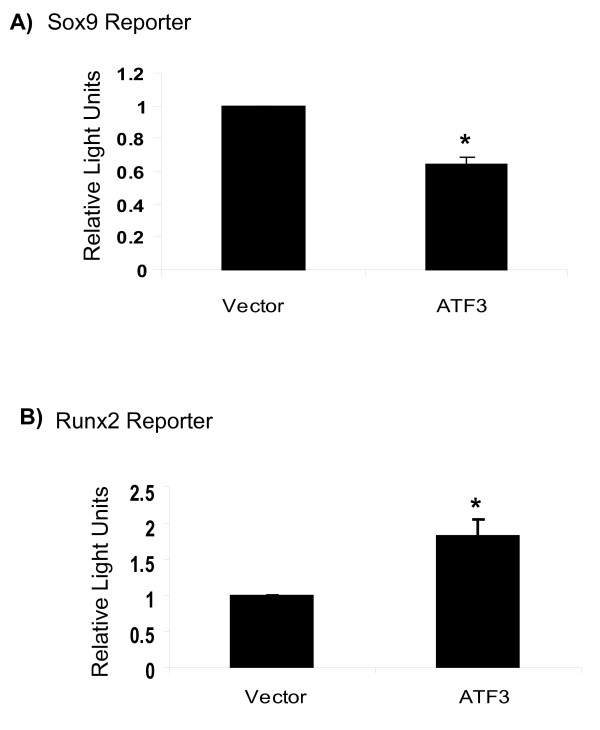
ATF3 suppresses Sox9-dependent transcription and stimulates Runx2-dependent transcription. Primary chondrocytes were cotransfected with SOX9 (A) or RUNX2 (B) reporter plasmids, pcDNA3 (control) or an ATF3 expression vector, and pRLCMV. 24 hours after transfection, cells were harvested, firefly luciferase activity was measured and normalized to Renilla luciferase activity. Data represent averages and SEM from three independent experiments, performed in quadruplicate each (*: p < 0.05). ATF3 overexpression suppressed SOX9-dependent transcription and stimulated RUNX2-dependent transcription.